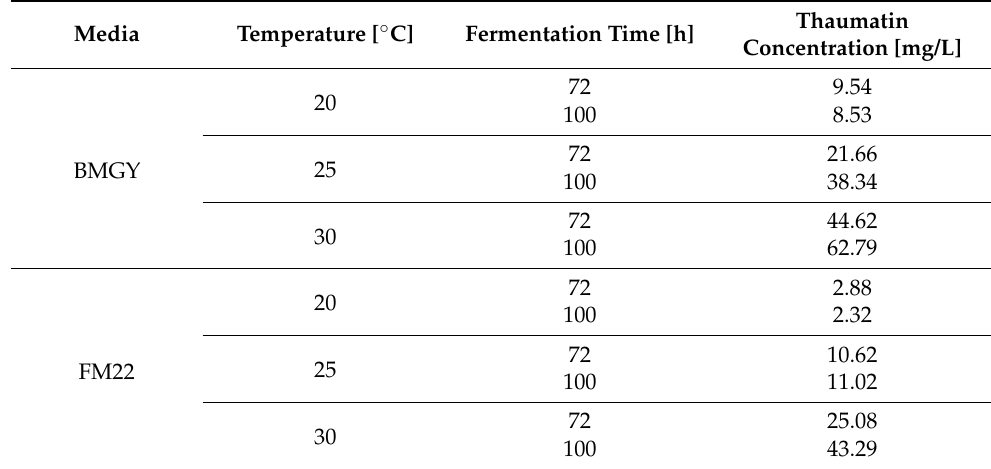
Table 3. Concentration levels of recombinant thaumatin II secreted into the media with an induction pH of 6.0 and grown at 20, 25 and 30 ◦ C as quantified using HPLC.